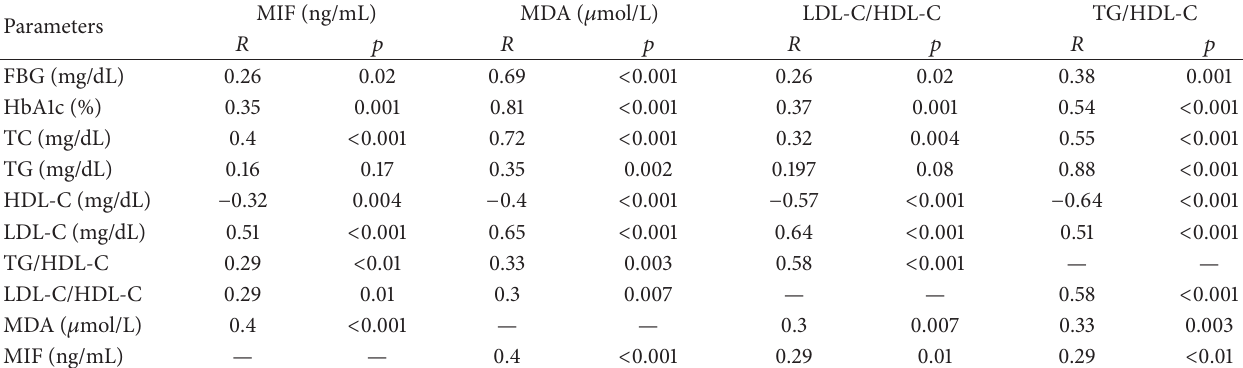
Table 3: Pearson’s correlation between potential predictors of diabetic complications and basic laboratory investigations. Parameters